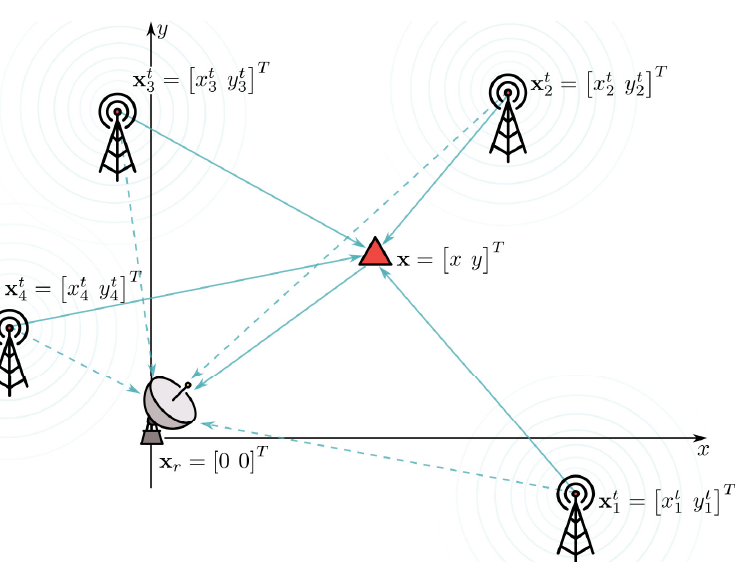
Figure 1. Illustration of the plaement of transmitters, receiver and a target and a distribution of signals in a considered localization